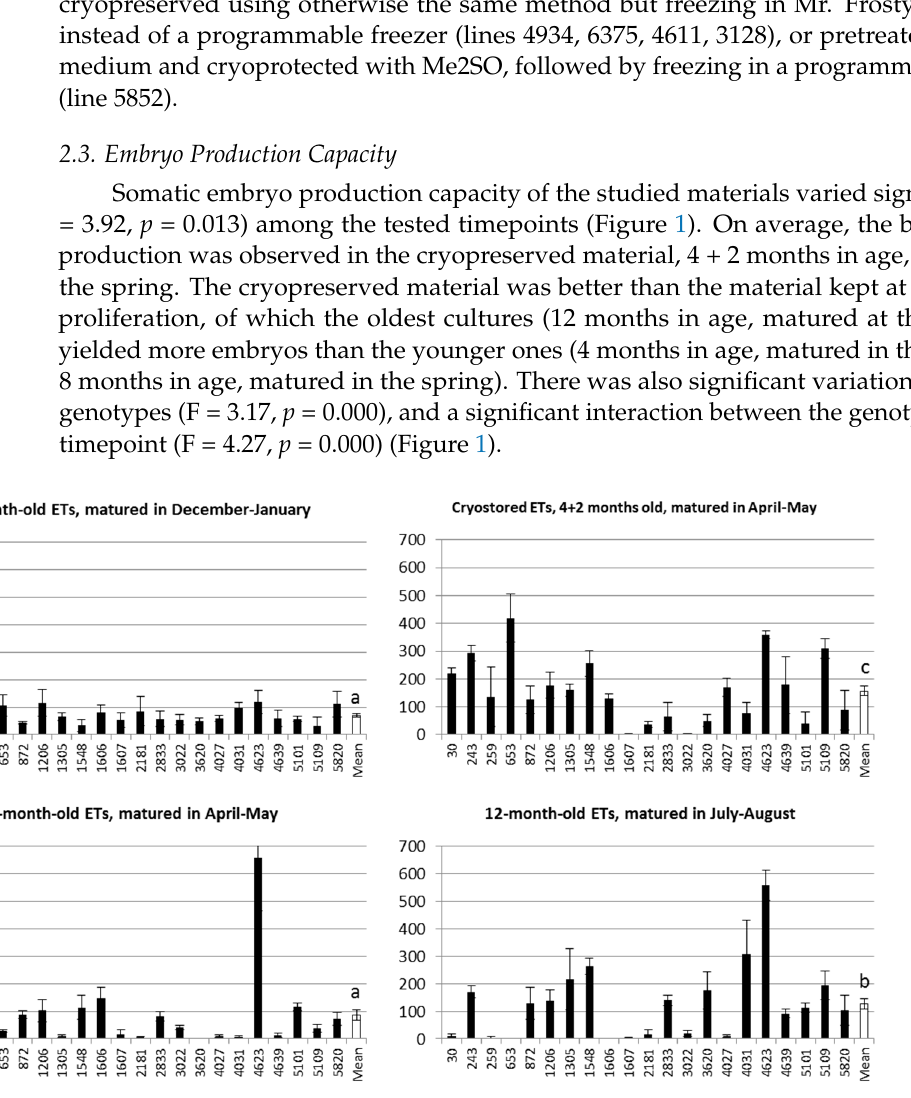
Figure 1. Somatic embryo production of 21 embryogenic lines of Norway spruce following 4, 8, or 12 months in continuous proliferation, or following cryopreservation at age of 4 months, thawing, and further proliferation for 2 months, n = 252. Number of embryos produced per gram of fresh weight (gFW) of embryogenic tissue with standard error are shown. The group means that differ significantly from each other (Student–Newman–Keuls multiple range test, p < 0.05) are marked by different letters.